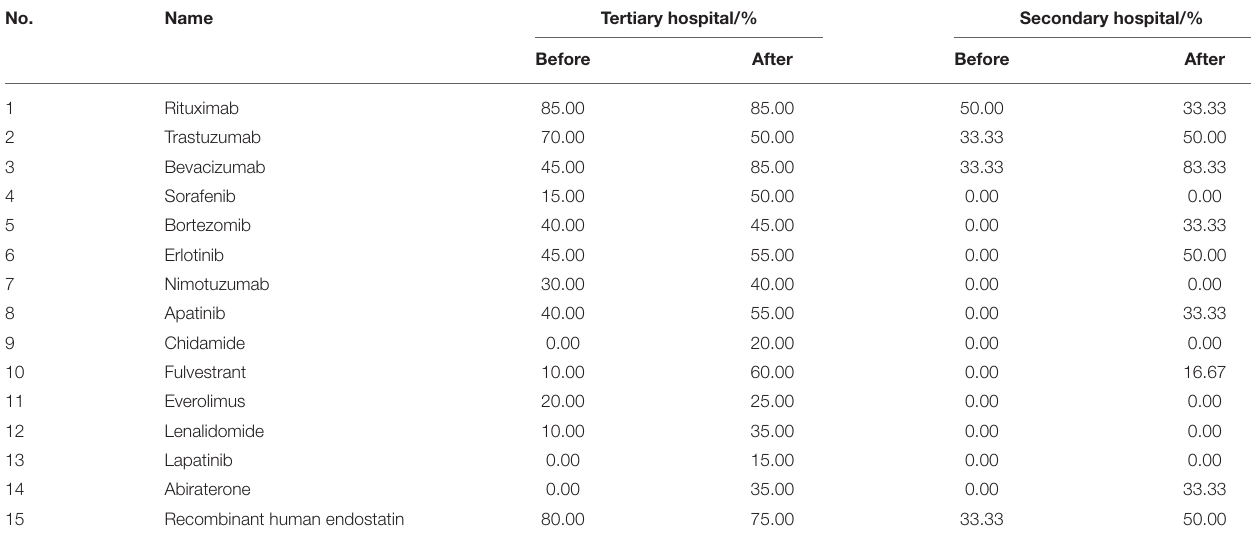
TABLE 4 | Availability of 15 innovative anti-cancer medicines before and after policy implementation.